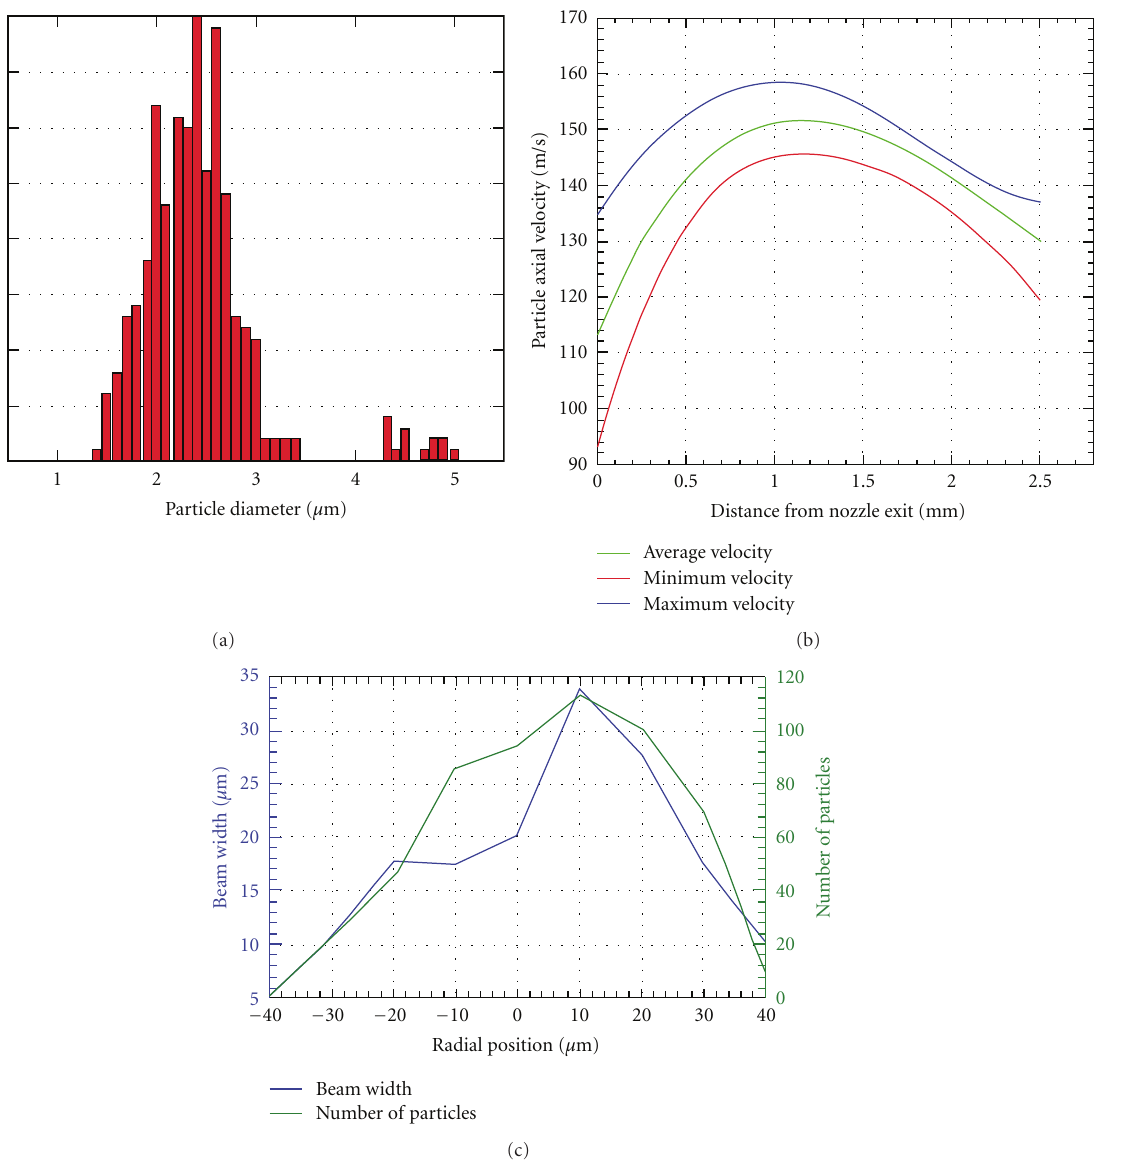
Figure 14: Shadowgraph results showing (a) histogram of particle size, (b) particle velocity versus distance from the nozzle exit, and (c) CW laser beamwidth and number of particles from shadowgraphy versus radial position (focus), from Mahmud et al. [86], Copyright 2010 ASME. Reprinted with